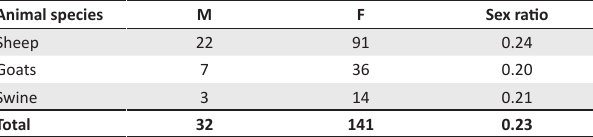
TABLE 2: Sex ratio in small ruminants and pigs suspected of tuberculosis at the abattoir from August 2017 to December 2017. Animal species M F Sex ratio Sheep